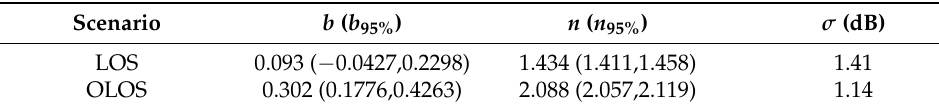
Figure 10. Measured and CIF path loss model in OLOS conditions. Table 5. Parameters of the multi-frequency CIF